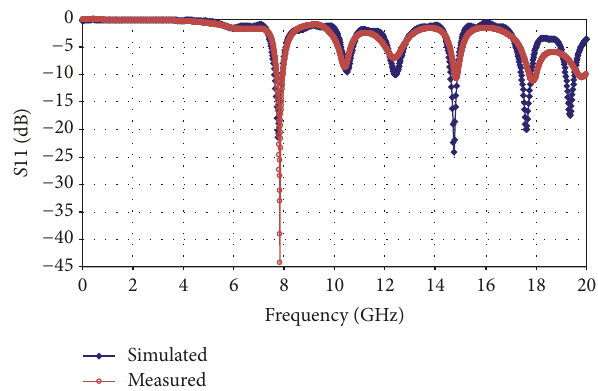
Figure 1: Results of the simulated and measured 𝑆 11 values of the conventional microstrip